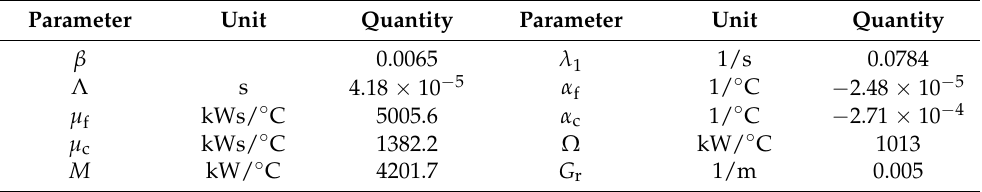
Table 1. Dynamical parameters of NHR200-II at the middle of fuel cycle around full power. Parameter